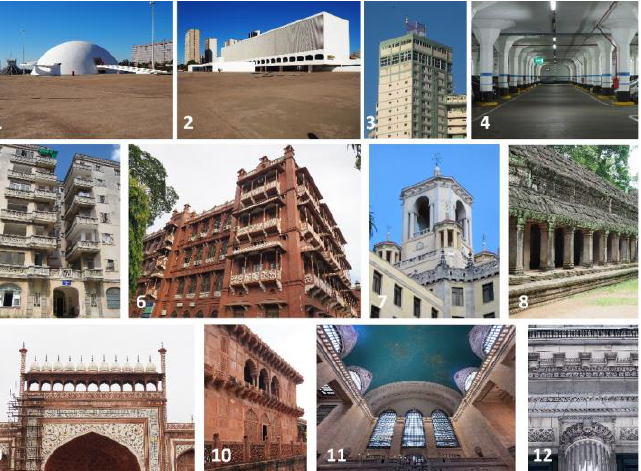
Figure 1. The images used for the study: 1,2 Brasília, Brazil; 3 Vedado, Havana, Cuba; 4 Buenos Aires, Argentina; 5 Havana, Cuba; 6 Dhaka, Bangladesh; 7 Vedado, Havana, Cuba; 8 Angkor, Cam- bodia; 9,10 Agra, India; 11,12 New York, USA. Original photos by Nir H. Buras, used here with permission. Photo editing by A.A. Lavdas.